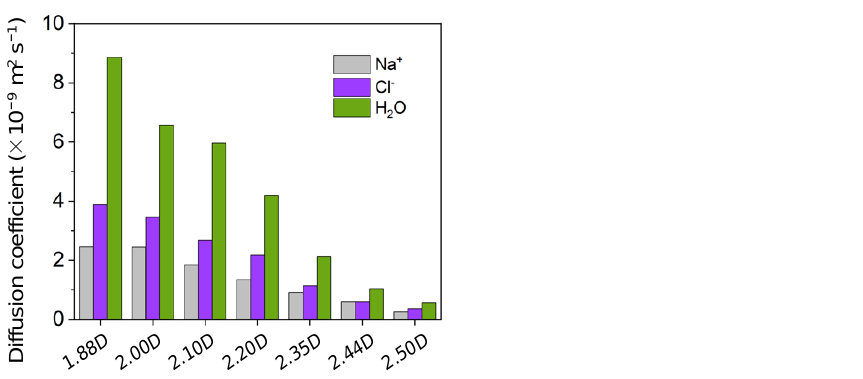
Figure 5. Self-diffusion coefficients for cations, anions, and solvents as a function of dipole moment.